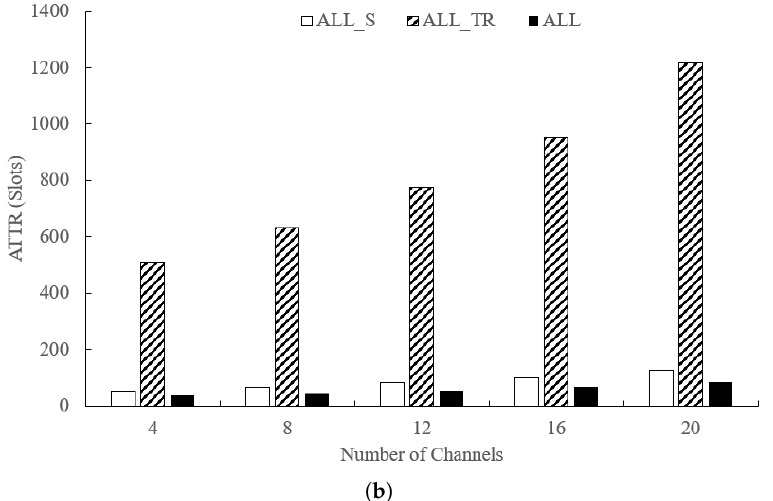
Figure 13. This figure displays the impact of shortening ID and allocating unfixed R frames on the performance of mesh topology in a synchronous network, as measured by two metrics: ( a ) throughput and ( b )